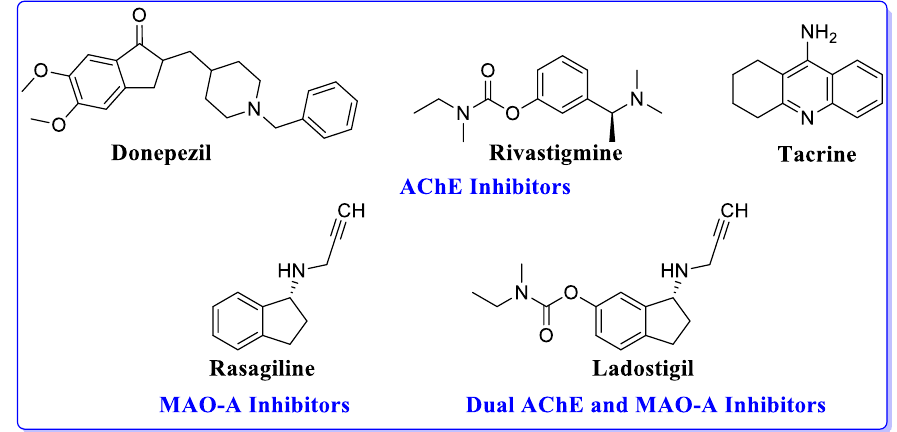
Figure 1. Structures of some FDA approved acetylcholinesterase ( AChE) and MAO-A inhibitors.